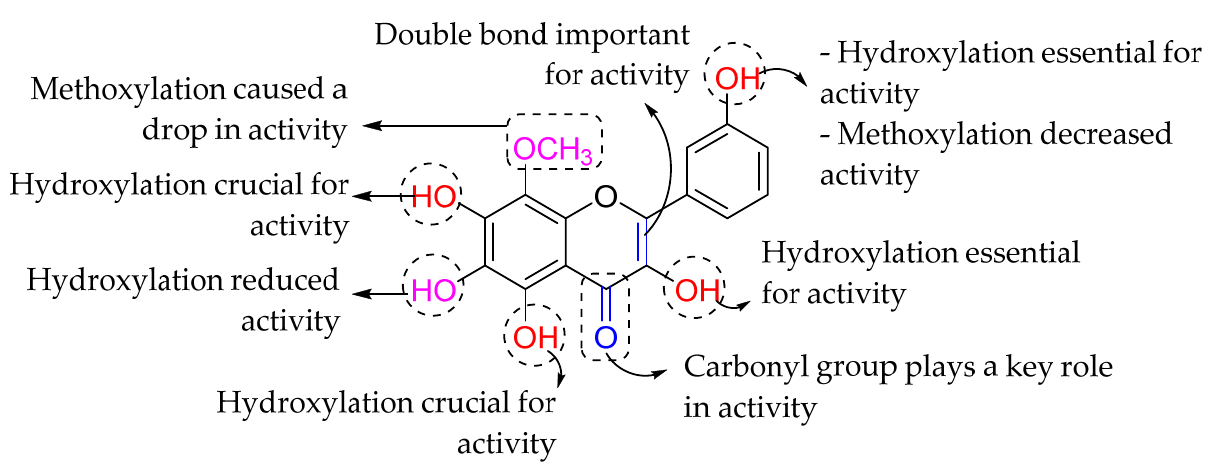
Figure 33. The chemical structures and the SAR of tested isoflavones [103].